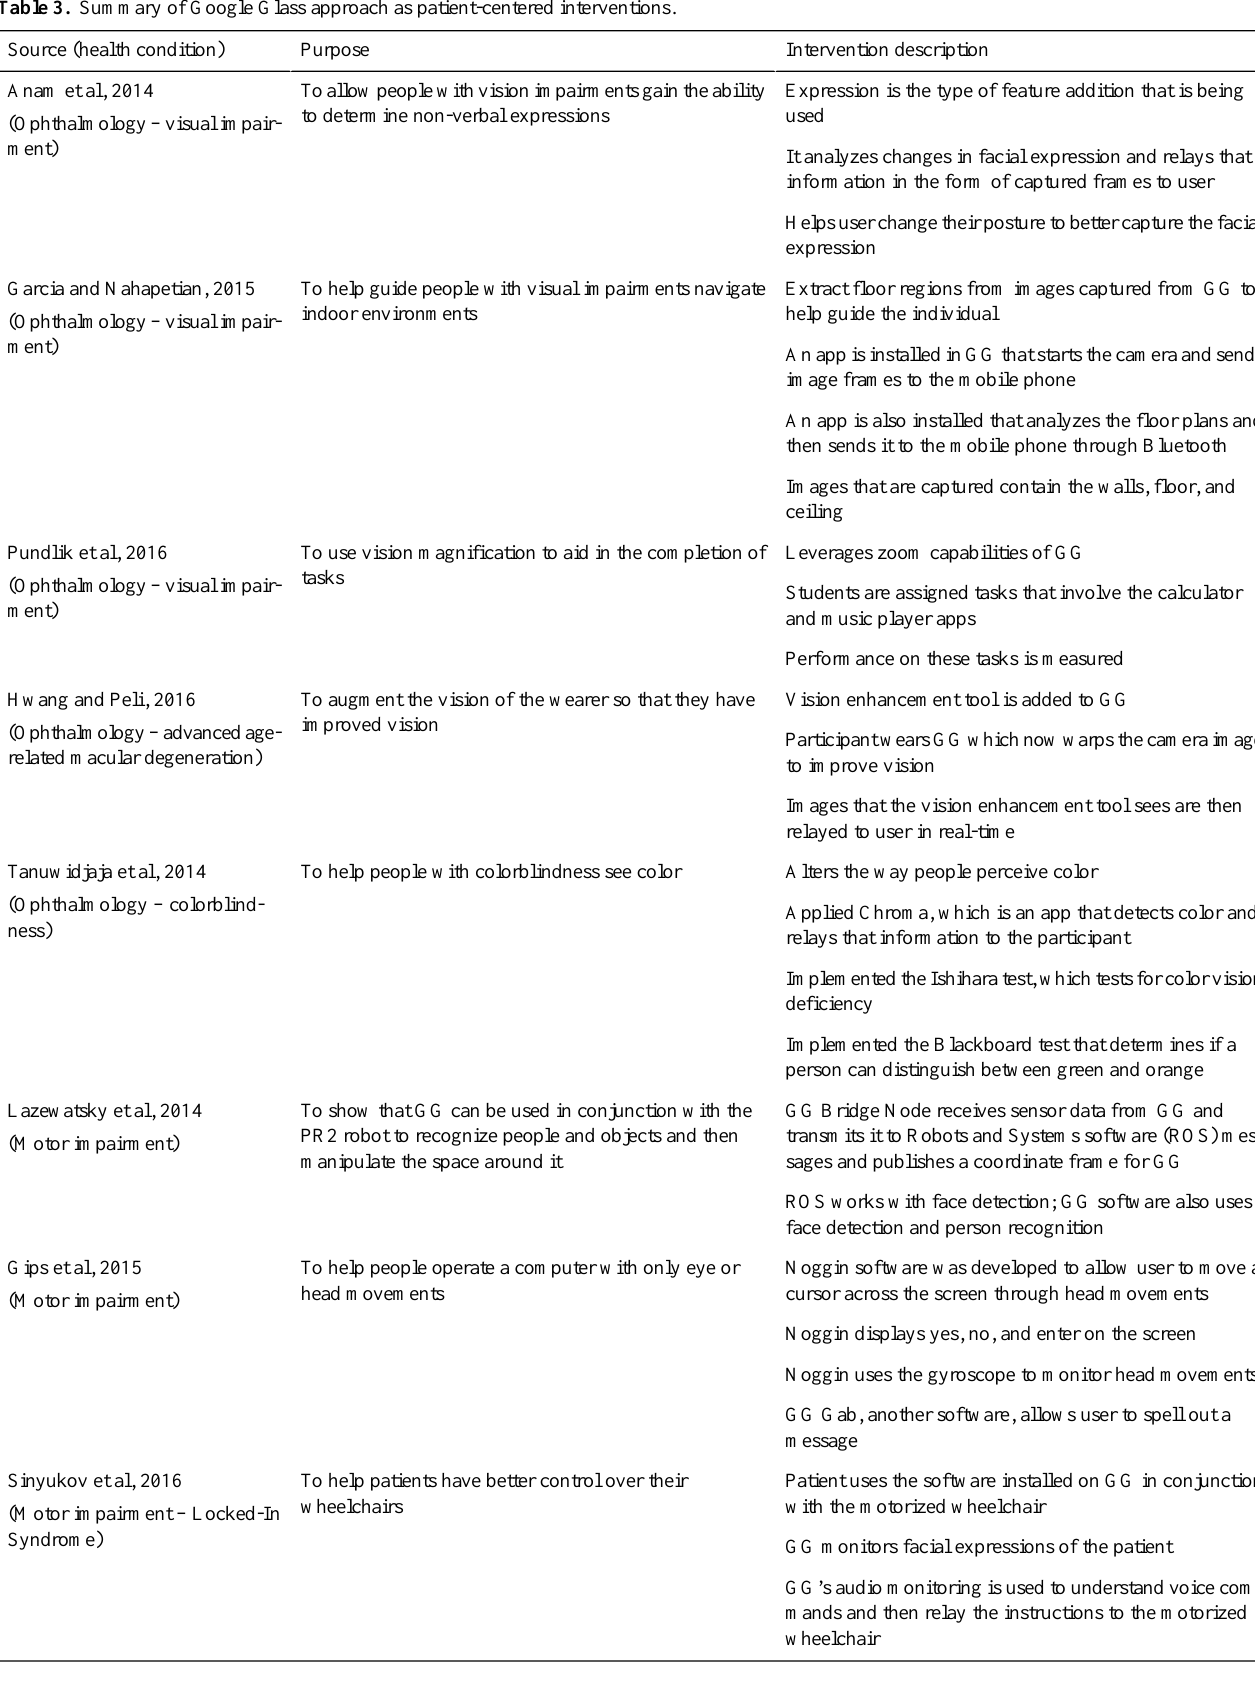
Table 3. Summary of Google Glass approach as patient-centered interventions.